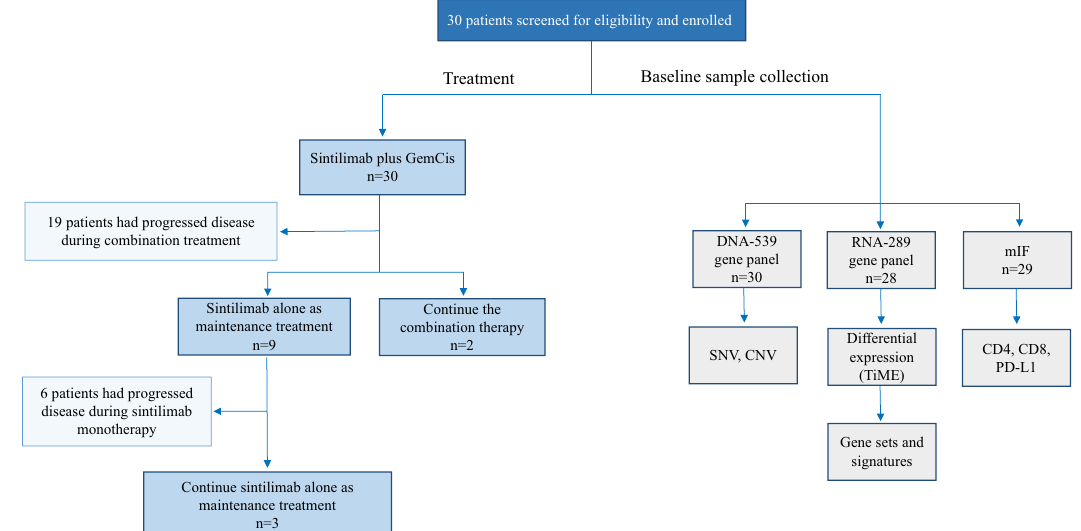
Fig. 1 | Clinical trial fl ow chart. Flow of participants in the